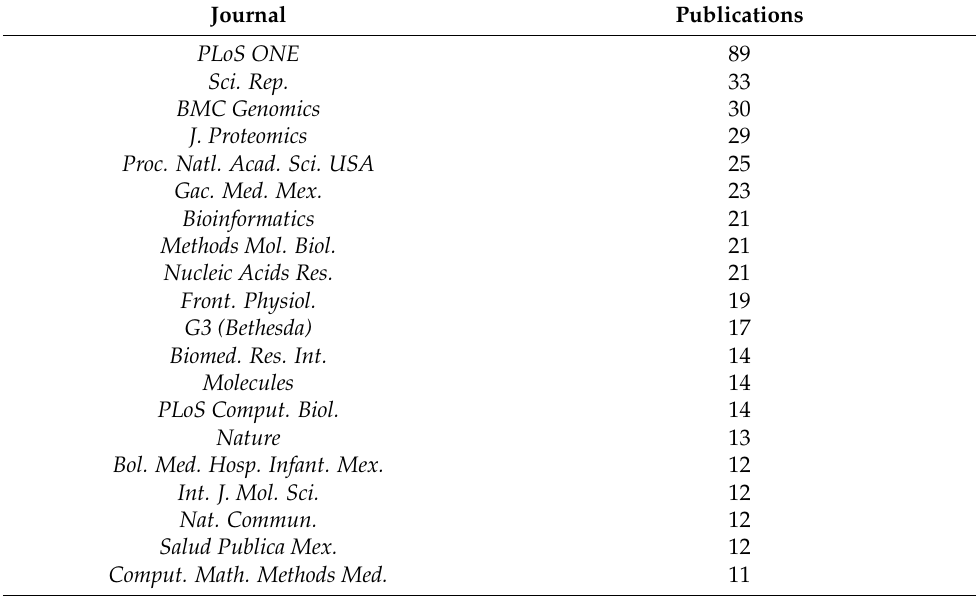
Table 1. Most relevant journals associated with Mexican bioinformatics (1994 to